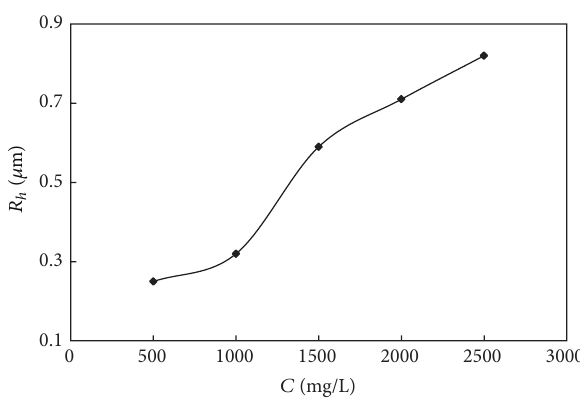
Figure 3: Relation between the hydrodynamic feature size and the concentration of polymer